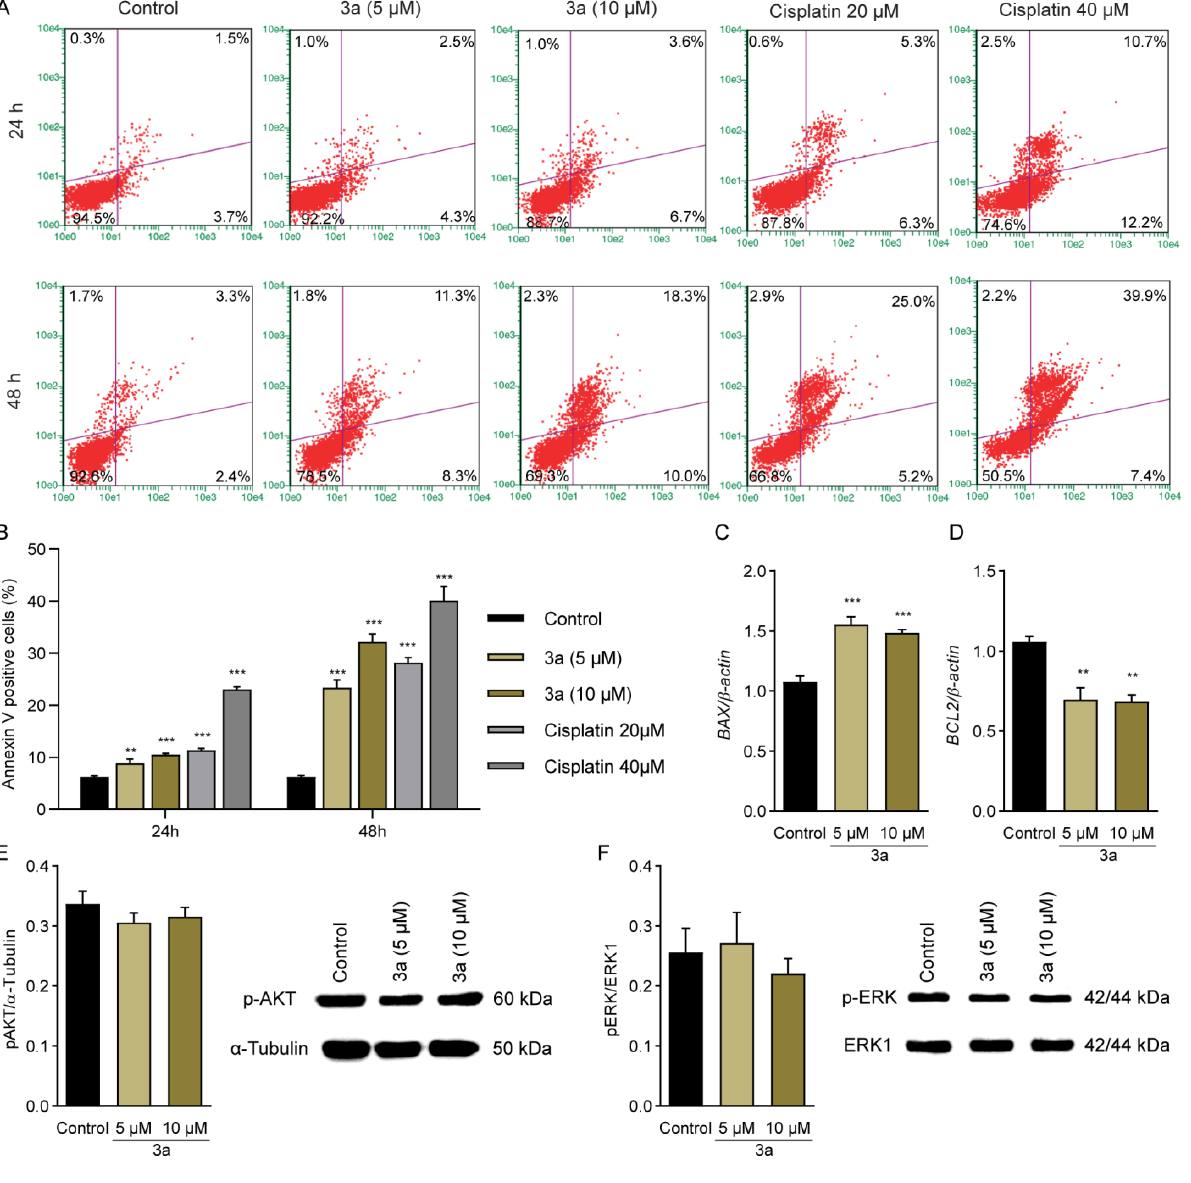
Figure 5 . Compound 3a induced apoptosis in SK-MEL-147 cells. ( A , B ) Representative dot plots and analysis of annexin V/7-AAD assay performed in SK-MEL-147 cells after 24 and 48 h of treatment with 3a . Viable cells (lower left quadrants), early apoptosis (lower right quadrants), late apoptosis (upper right quadrants), and necrotic cells (upper left quadrants); ( C , D ) Relative mRNA expression of BAX, respectively, determined by qPCR in SK-MEL-147 cells treated with 3a at 5 and 10 µM for 24 h; ( E , F ) Relative protein levels of p-AKT ( E ) and p-ERK ( F ) by immunoblot in SK-MEL-147 cells treated for 24 h with 3a at 5 and 10 μM. α -tubulin and ERK-1 were used as a loading controls; ** p < 0.01 and *** p < 0.001 according to ANOVA followed by Dunnet post-test compared with control group.